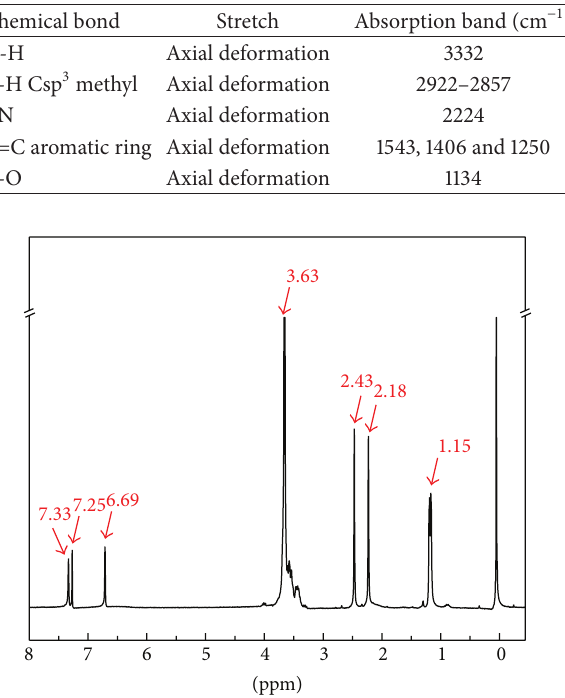
Figure 4: 1 H NMR spectrum of 4-hydroxy-2,5-dimethylbenzoni-